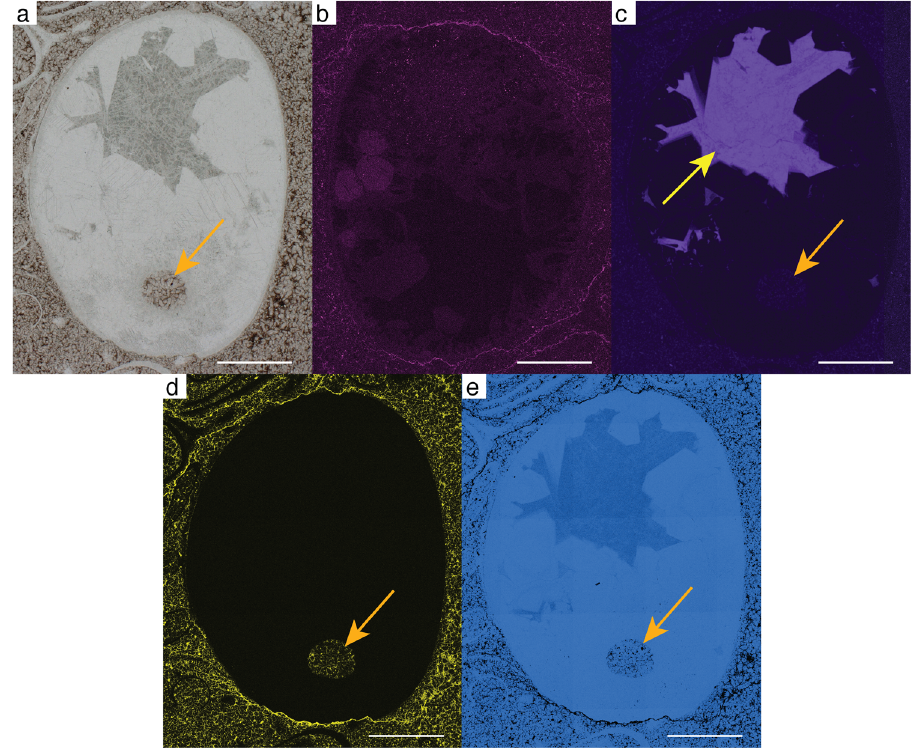
Fig. 2 Thin section and SEM-EDS images of specimen no. NFM F-2776. a Cross section of phragmocone showing the position of the siphuncle (orange arrow). Note that calcite spar cement fi lled the shell interior indicating that it formed a closed system during the earliest diagenetic stage. Only the siphuncle was fi lled with mud, thus providing strong evidence for its connection with the body chamber. b – e Colour-coded SEM-EDS element mappings of NFM F-2776. b Magnesium. The chamber and parts of the shell are partly enriched in Mg. c Manganese. Only the inner part is enriched in Mn (yellow arrow), whereas the siphuncle (orange arrow) is Mn-depleted. d Aluminium. The siphuncle (orange arrow) and the host rock are enriched in Al, whereas the phragmocone is Al-depleted. e Calcium. The phragmocone is enriched in Ca. Scale bar is 1 mm.